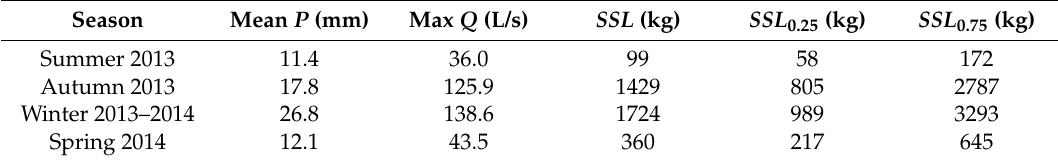
Table 4. Basic properties of the SSL , Q and P values for different seasons for the Kuzlovec torrent. Season Mean P